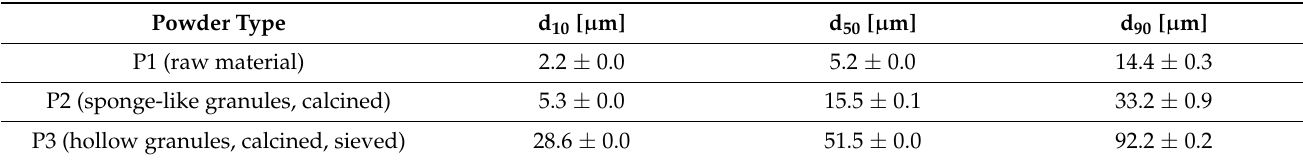
Table 3. Powder characteristics of HAp